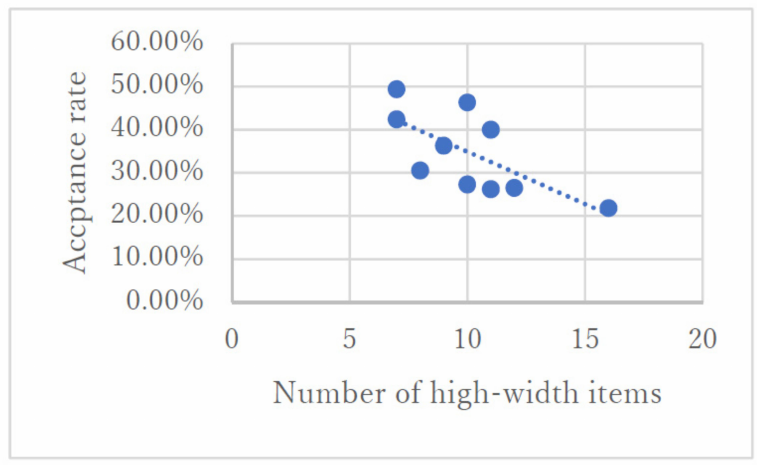
Figure 4. Distribution of the acceptance rates obtained using neal at each instance and the numbers of high-width items at those